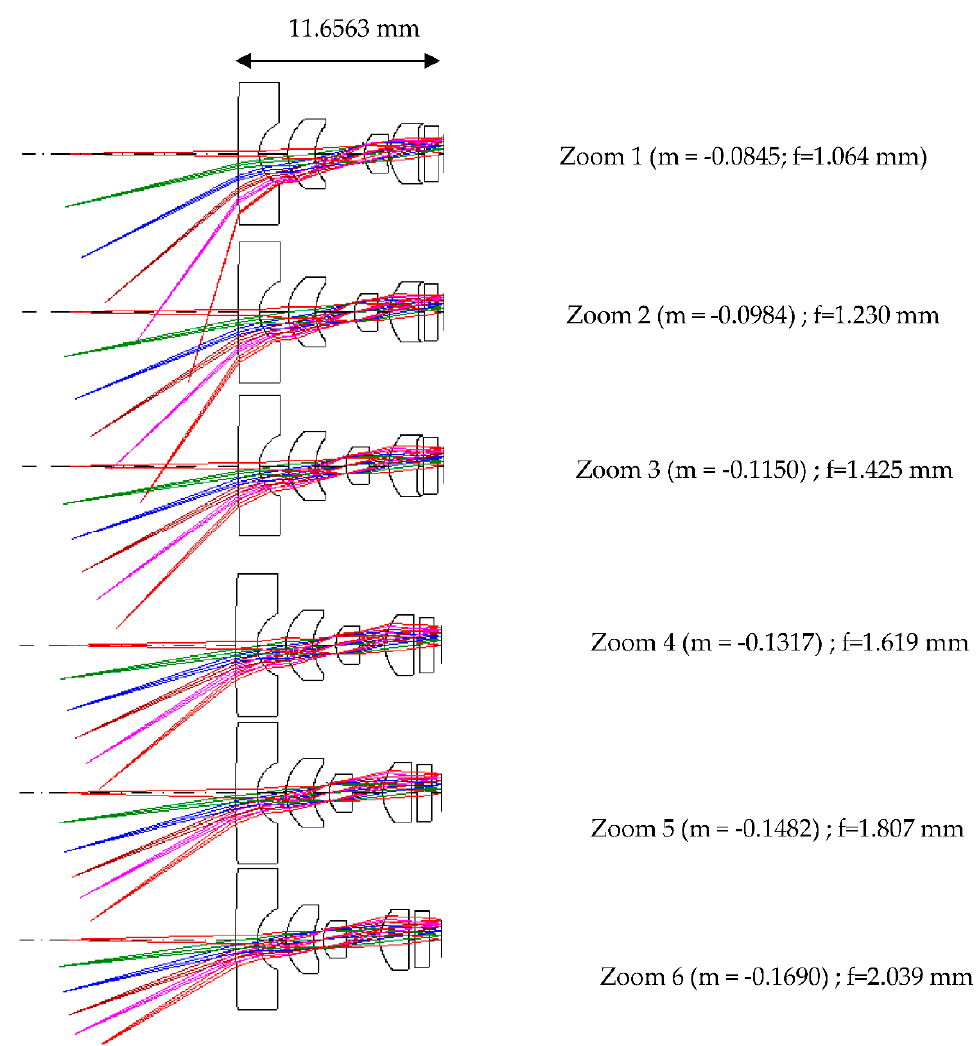
Figure 2. Lens diagrams of the 2× zoom lens at different magnifications.